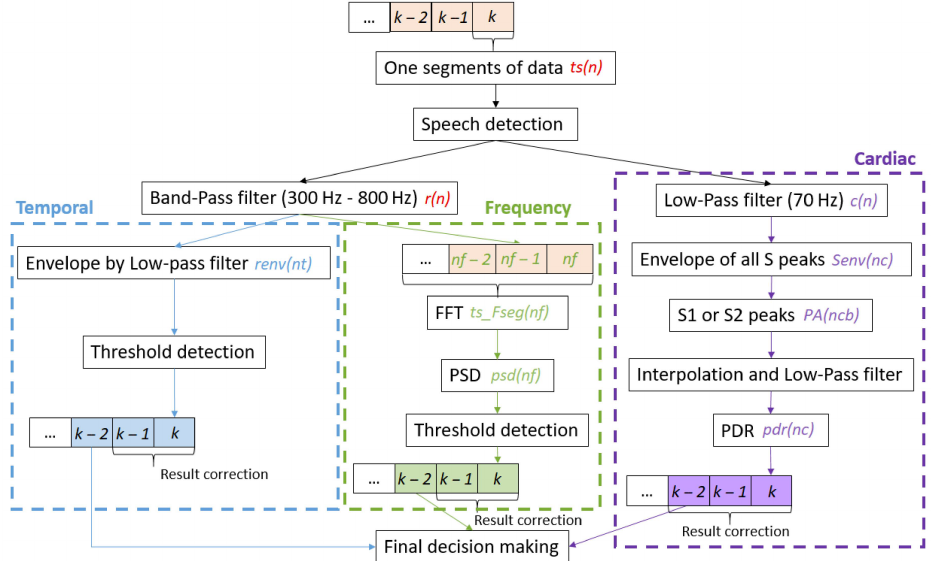
Figure 4. Diagram of the detection